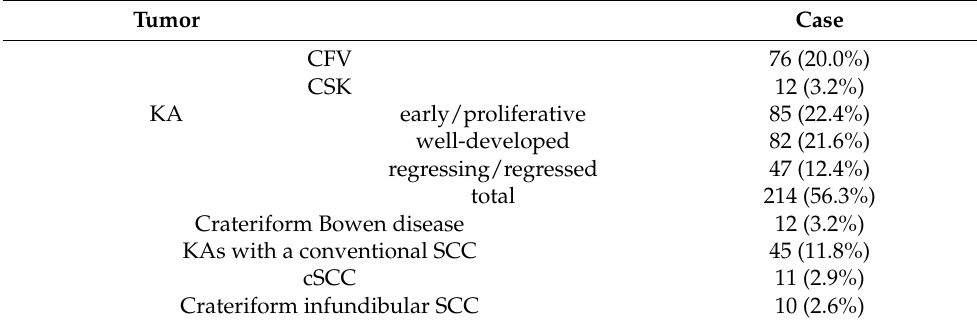
Table 2. Incidence of crateriform epithelial